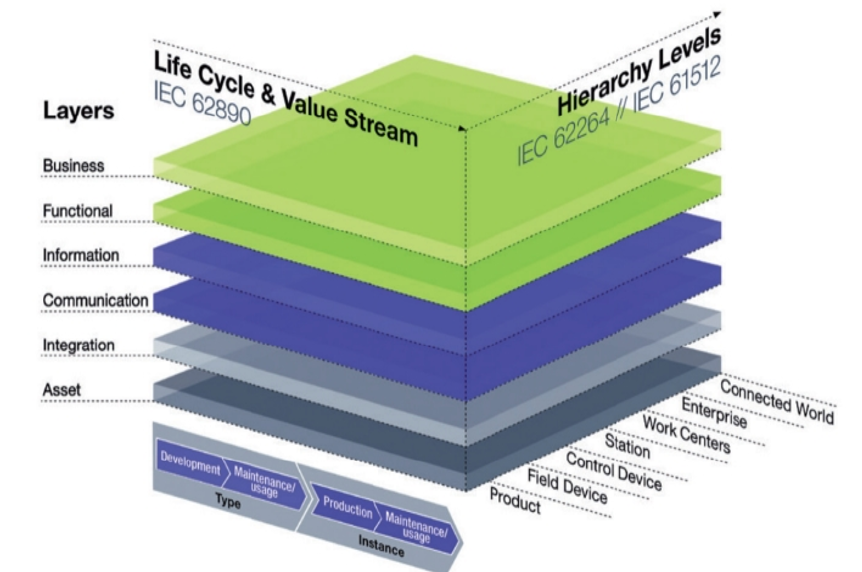
Figure 9. Reference Architectural Model Industrie 4.0 (RAMI 4.0). Source: Plattform Industrie